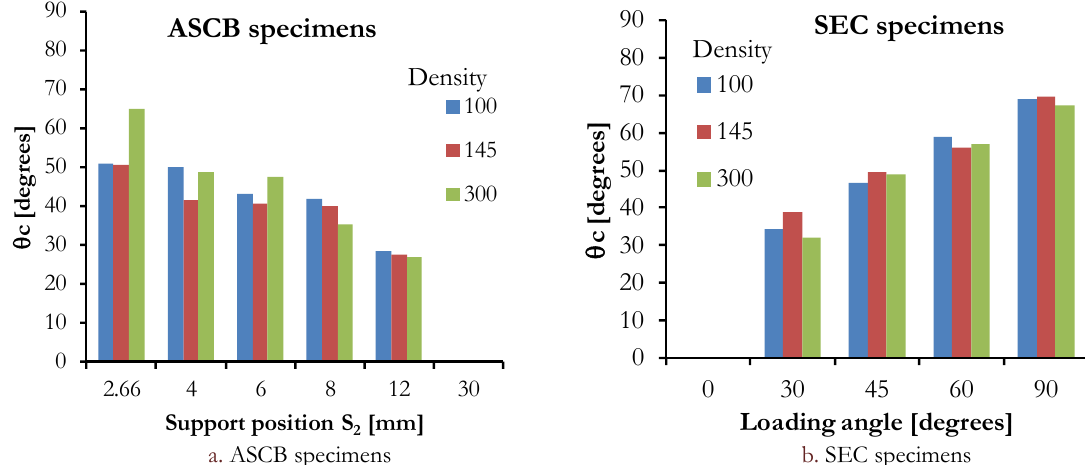
Figure 8 : Effect of density on crack initiation